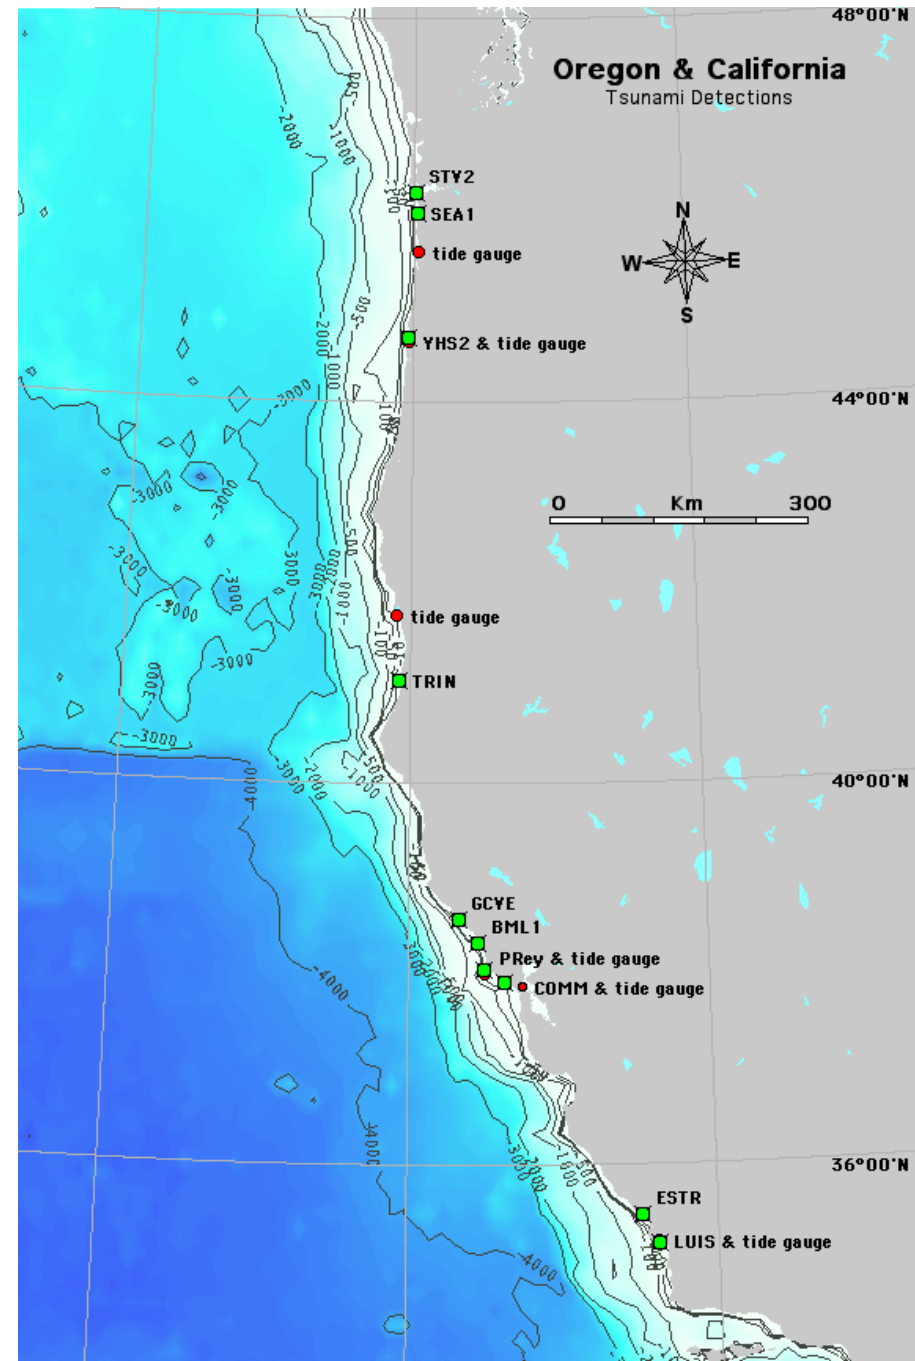
Figure 7. The location of the radars and tide gauges on the US West Coast, and the offshore